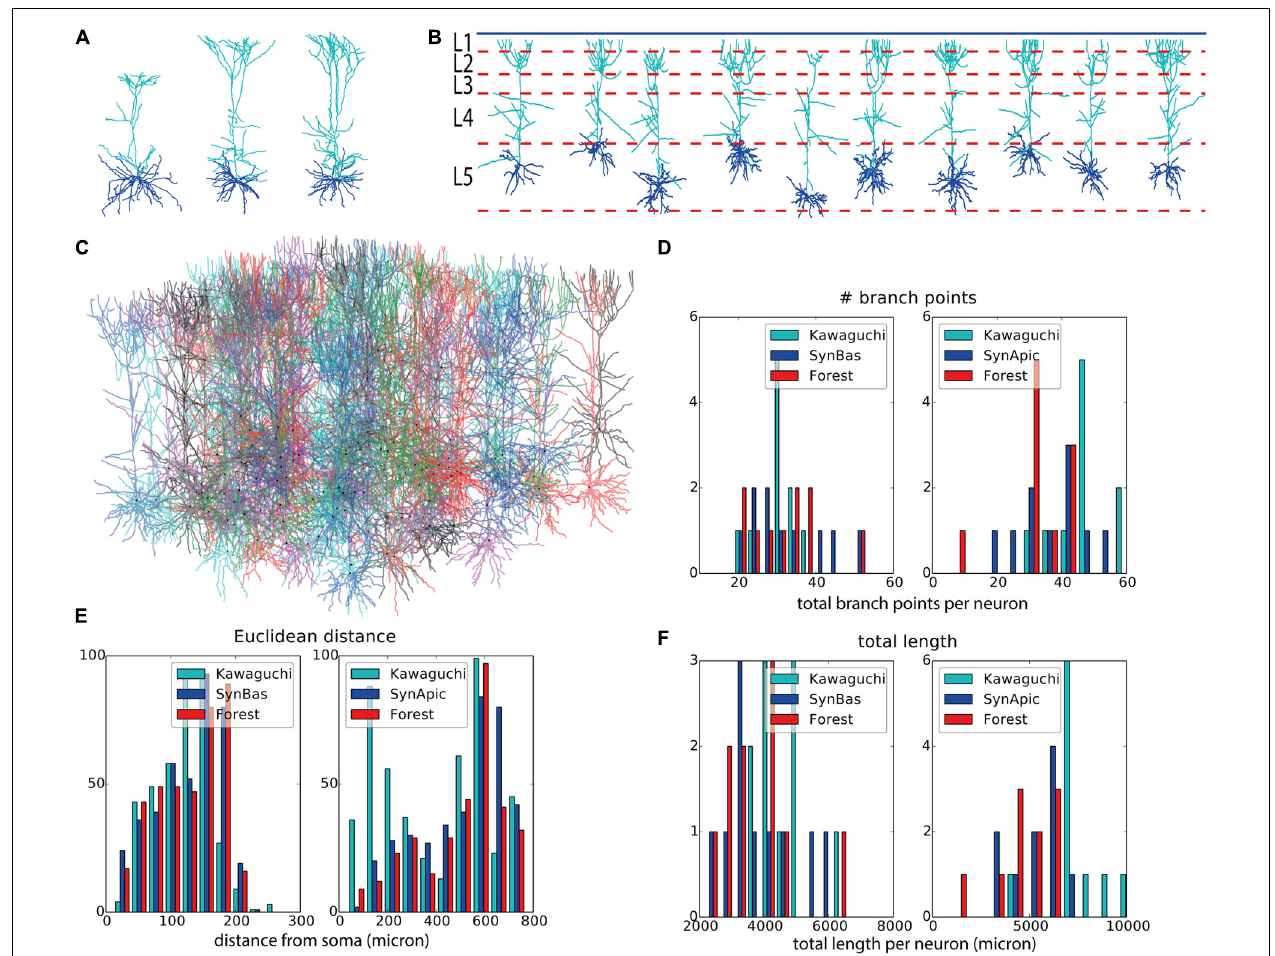
FIGURE 4 |Validation of generated layer 5 pyramidal neurons. (A) Experimentally reconstructed layer 5 pyramidal neurons (from the Kawaguchi archive). (B) Virtual morphologies generated by NeuroMaC. Simulated laminar structure (L1–L5, from top to bottom) indicated by dashed lines; blue line represents the pia. (C) Forest of 100 simultaneously generated, non-overlapping pyramidal neurons. (D–F) Quantitative comparison. Population morphometrics are shown for the